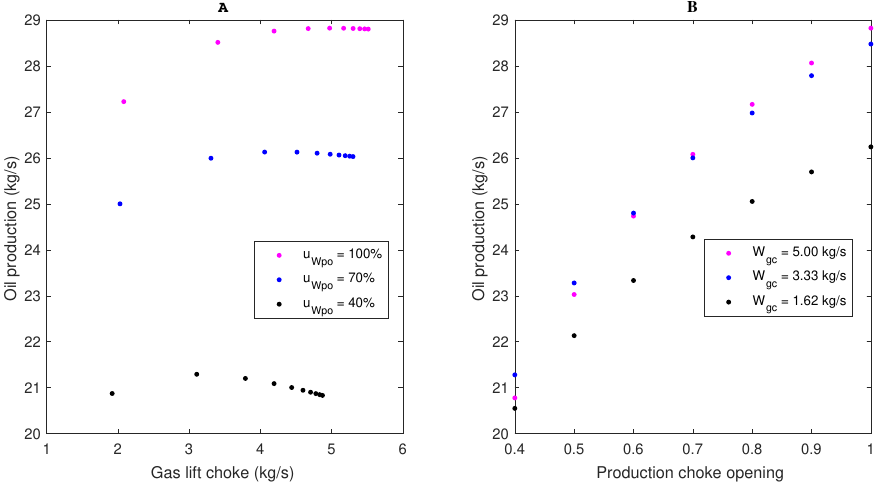
Figure 6. Steady state profile of w po : changes in ( A ) gas lift flow; and ( B ) production choke valve opening—Rojas Soares et al. model